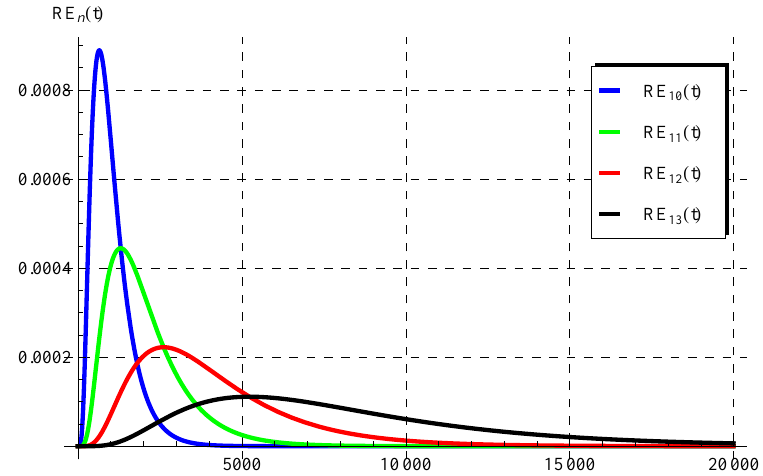
Figure 5. The residuals RE r ( t ) , r = 10,11,12,13 in Equation (76) at λ = 1, a = − 2, b = 1, and c = 1